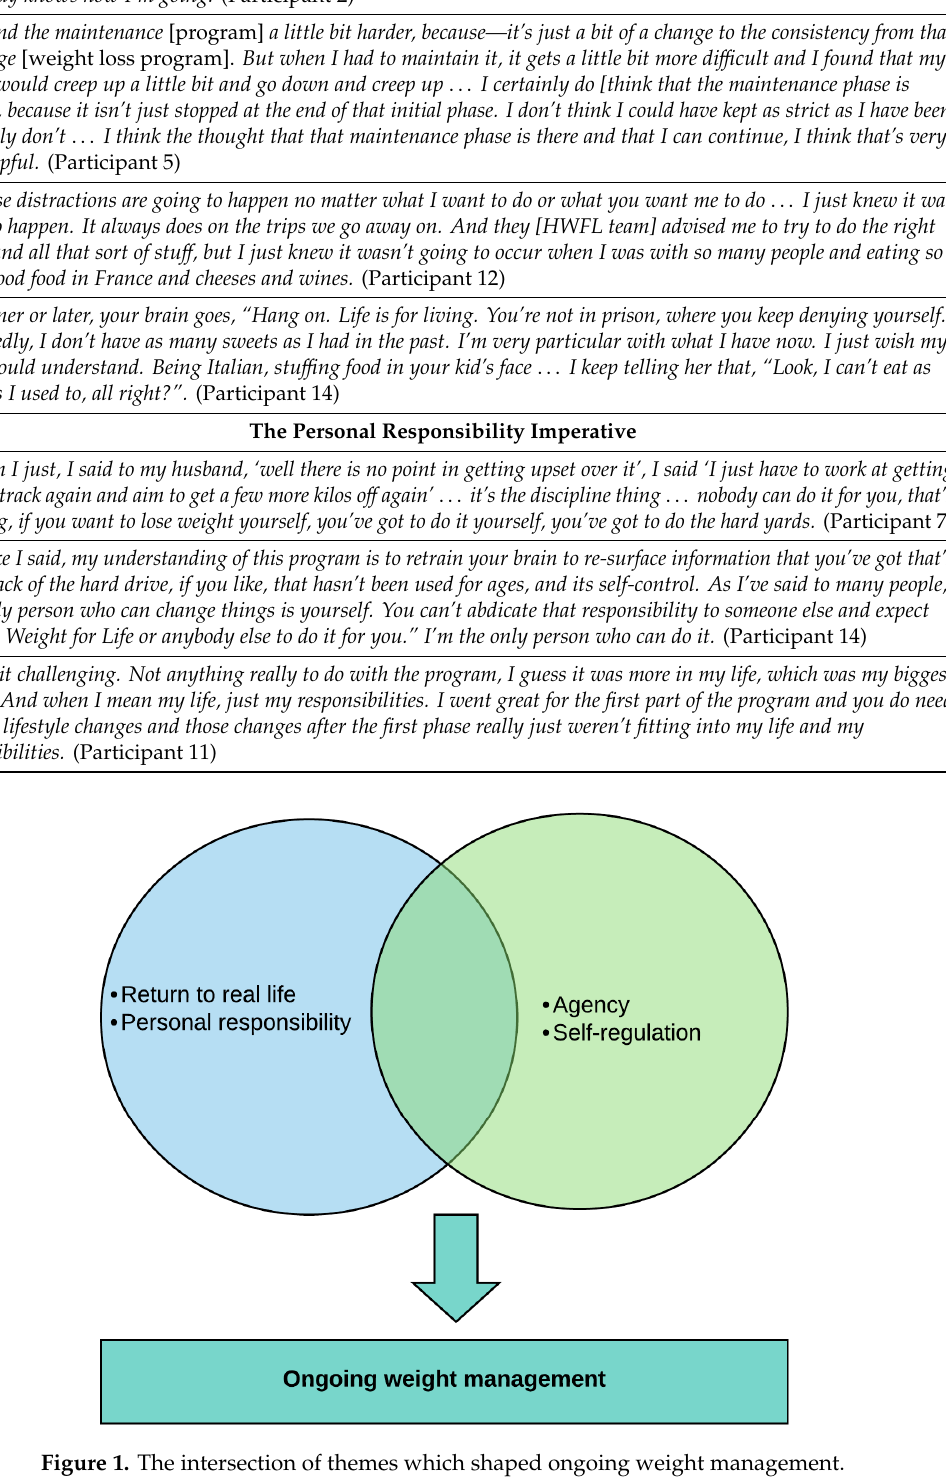
Figure 1. The intersection of themes which shaped ongoing weight management.